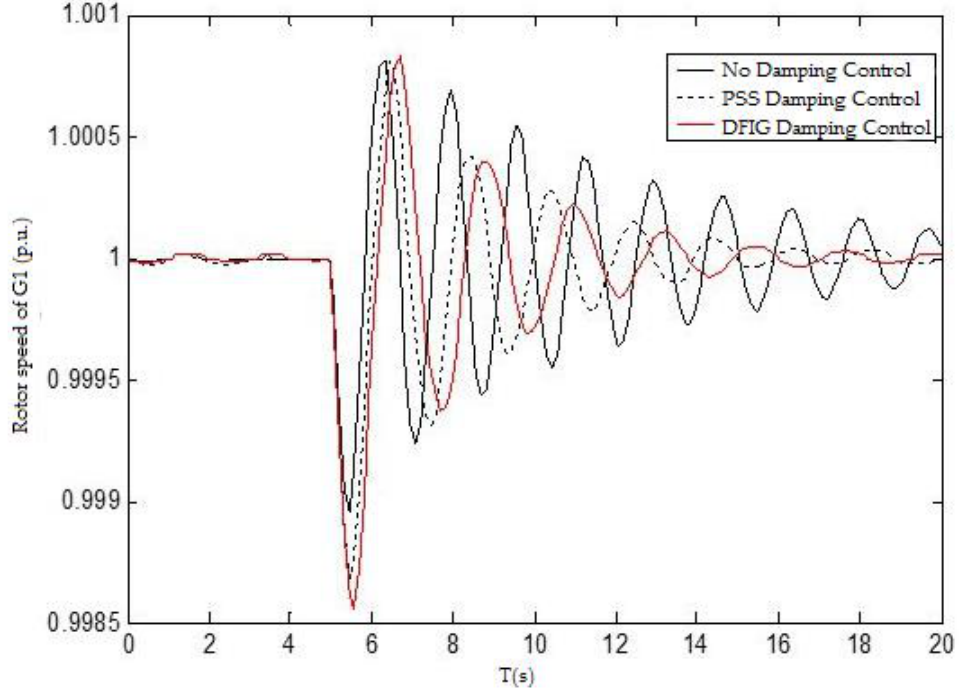
Figure 8. Dynamic response of rotor speed of G1 adopting novel DFIG damping control.